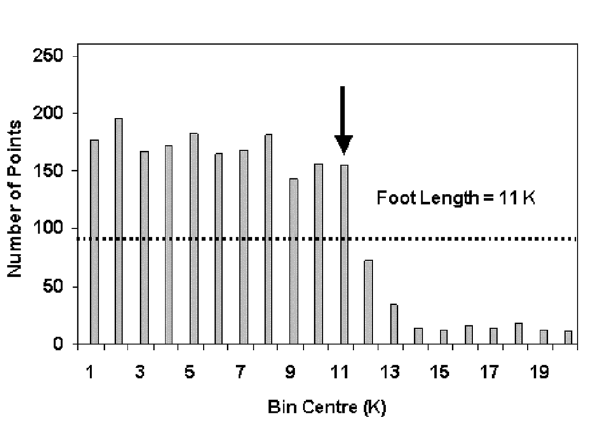
Fig. 4. The number of points per bin of 1K in width. The point at which the number of points drastically decreases (to less than 50% of the average of the previous bins) was assigned as a clear foot.